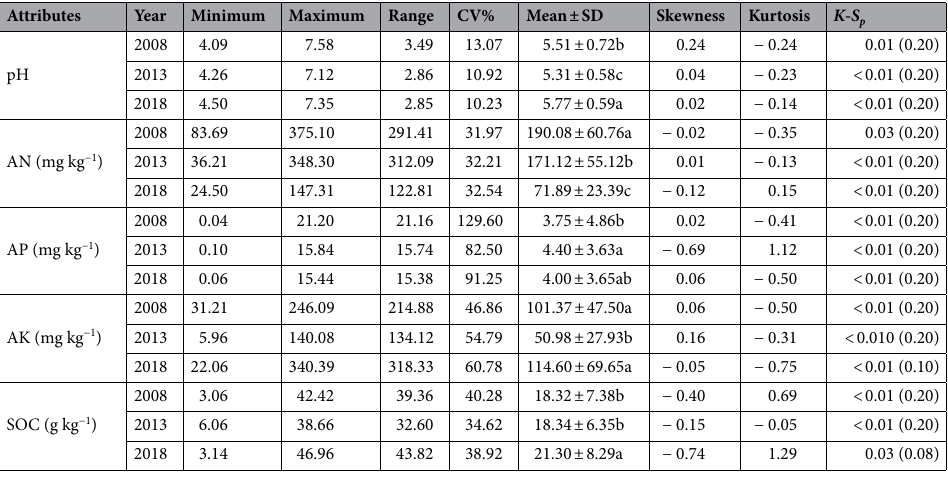
Table 1. Descriptive statistics of the soil attributes. AN available nitrogen, AP available phosphorus, AK available potassium, SOC soil organic carbon. Different letters in the same variable indicate significant differences among years at P < 0.05 level. CV: coefficient of variation; K-S p : significance level of Kolmogorov– Smirnov test for normality. The K-Sp values in brackets were calculated after